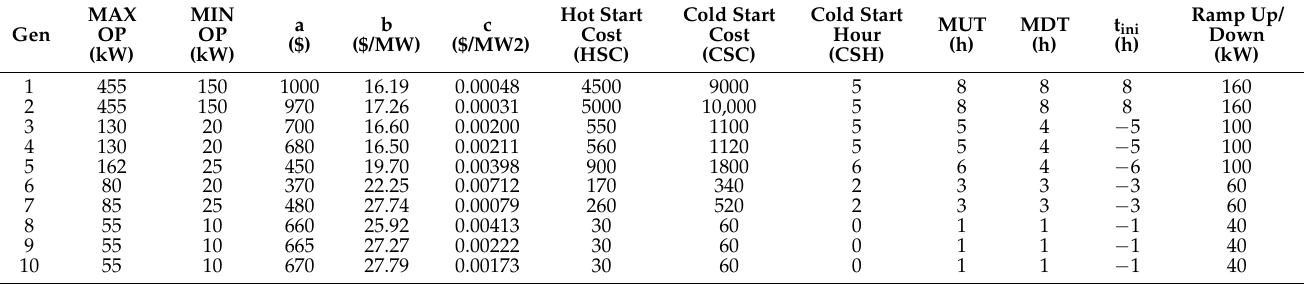
Table 4. Generator